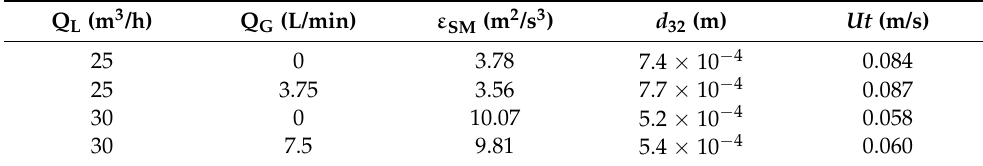
Table 1. Results of the procedure for the determination of the d 32